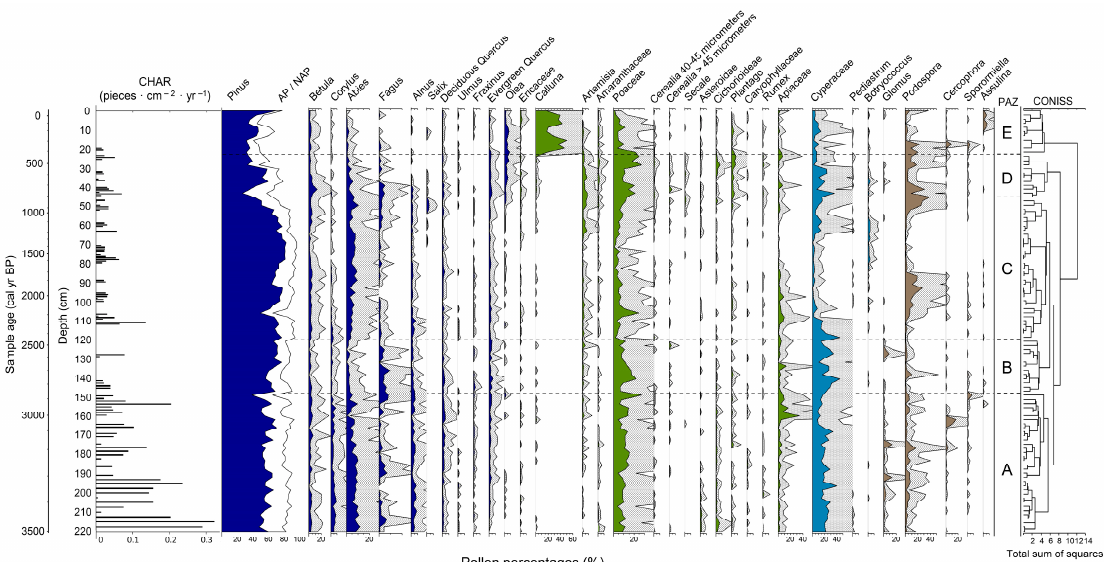
Figure 5. Diagram of pollen and non-pollen palynomorphs percentages and charcoal accumulation rate (CHAR) of the Clots de Rialba peat bog (CdR1 record). Light silhouettes indicate 5 × exaggeration. Pollen assemblage zones (PAZ) determined by a constrained incremental sum of squares cluster analysis (CONISS) are shown. In dark blue, arboreal taxa; in olive green, shrubs; in blue, hygrophytes and hydrophytes; and in brown, algae and fungi are represented.